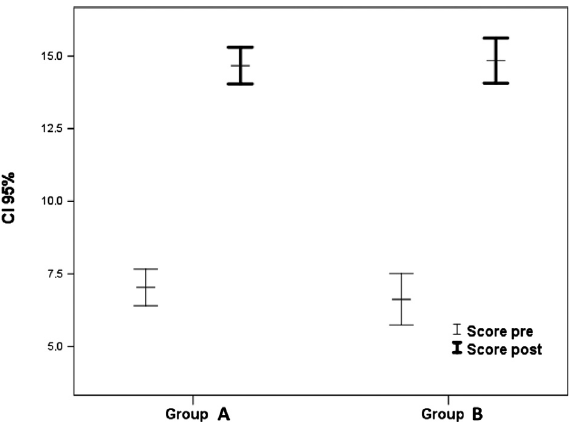
Figure 4. Merle d’Aubigné score pre- and post-surgery. Group A (<2.5 cm) vs. group B (>2.5